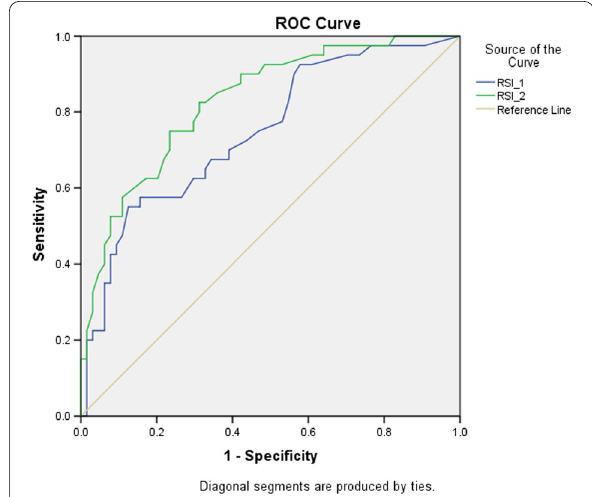
Fig. 4 Receiver operating characteristic curve of RSI1 and RSI2. ROC curve showing the RS1 value curve (blue colour) and the RSI2 value curve (green colour) which are above the reference line. The curve of the RSI1 and RSI2 values has a fairly wide area under the curve and has good sensitivity as a measuring tool. From the figure, it can be seen that the area under the RSI2 curve is wider than the RSI1 curve